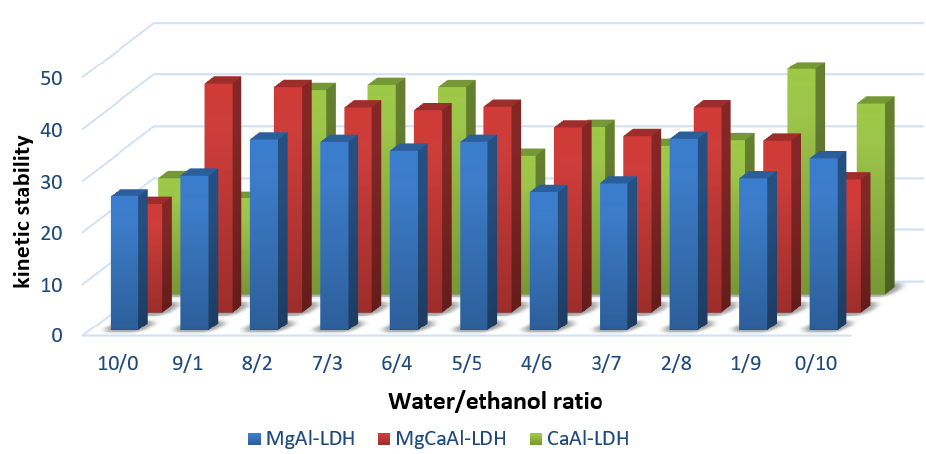
Figure 3. Kinetic stabilities of the LDH dispersed in solvents after 300 min.